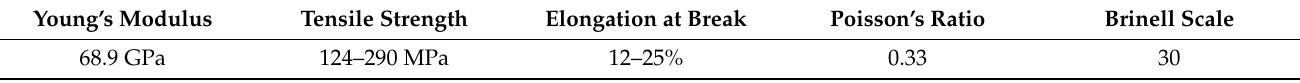
Table 2. Mechanical properties of 6061 aluminum alloy.